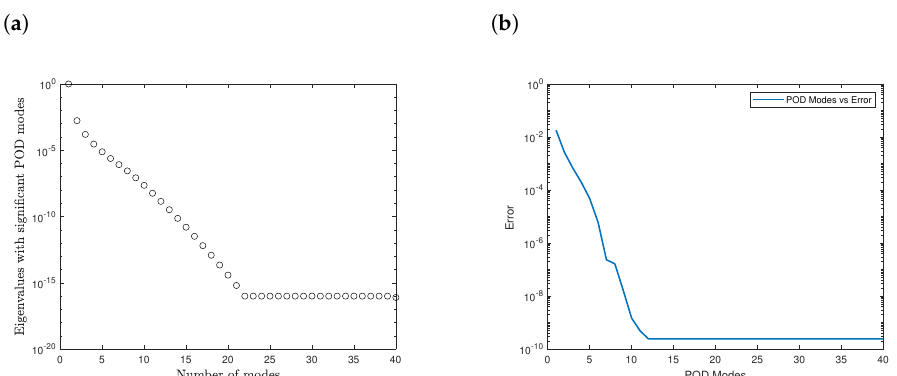
Figure 1. ( a ) POD modes for linear reaction diffusion equation. ( b ) Number of POD modes vs. error. Figures 2a,b and 3a show the surface plots of the exact, UPFD and EUPFD solutions of linear ADR. Figure 3b shows the increase in error when the POD modes increased.